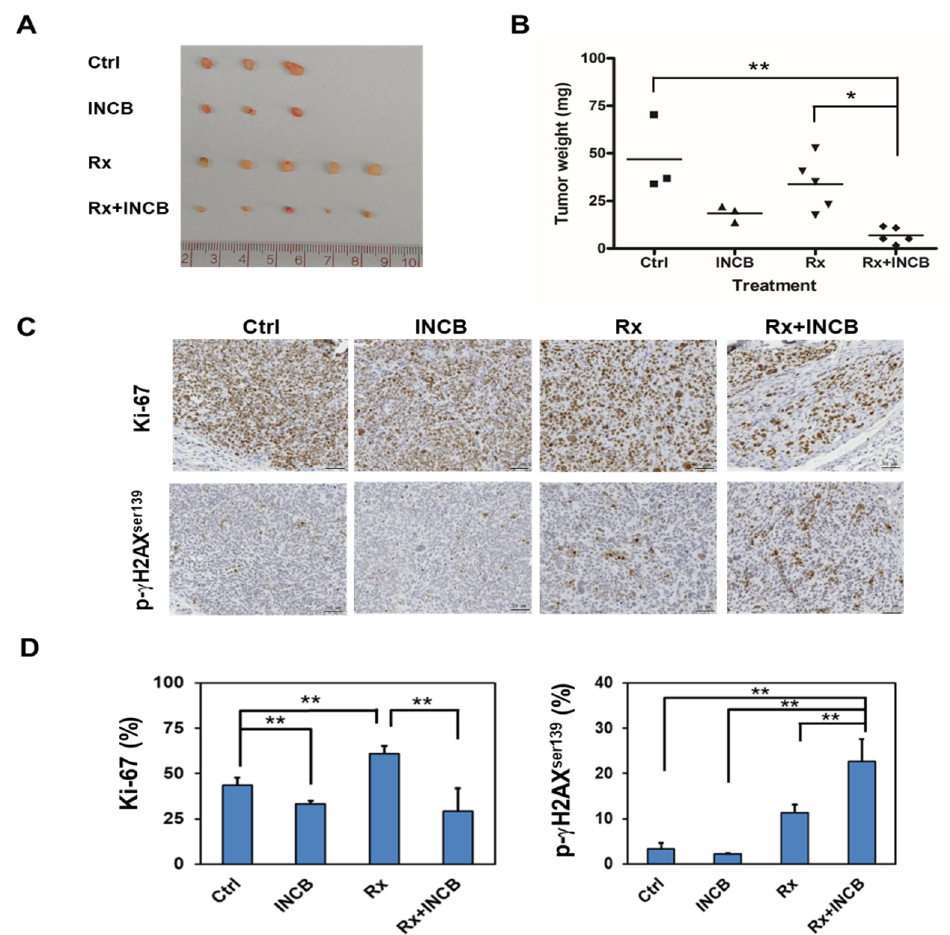
Figure 6. IDO1 inhibitor enhances the e ffi cacy of radiotherapy in vivo. 1 × 10 5 of SiHa tumorsphere cells were subcutaneously injected to nude mice for tumor growth. After the tumor volume reached 50 mm 3 , the mice were divided into four groups of non-treated (Ctrl), INCB-024360 treated (INCB), radiotherapy (Rx), or INCB-024360 plus radiotherapy (INCB + Rx). For the INCB or INCB + Rx group, mice were injected once with 50 mg / kg INCB-024360 intraperitoneally before radiotherapy. For the Rx or INCB + Rx group, mice received 2 Gy radiation per day for total 10 Gy. Mice were sacrificed at day 30 after the last radiation treatment and the xenografted tumors were taken out for picturing ( A ) and weighting ( B ). The expression of Ki-67 or p- γ H2AX ser139 was determined by para ffi n section followed by immunohistochemical staining ( C ). The inserted bars indicated 50 µ M. The quantification results were performed by TissueFAX software ( D ). * p < 0.05; ** p < 0.01. The experiments were repeated two times and data from one experiment were presented.